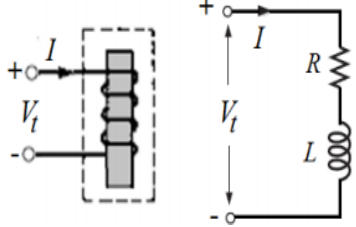
Figure 4 Representation of the electro-magnetic subsystem of solenoid model